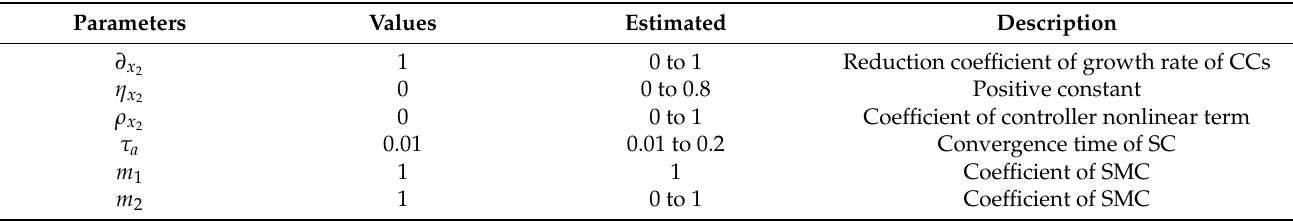
Table 2. Different controllers using parameters with